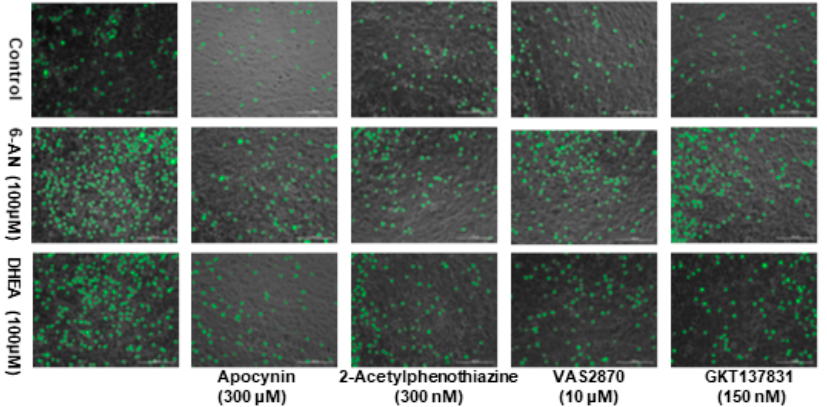
Figure 4. The effect of G6PD and NOX pharmacological inhibitors on NADPH oxidase activity, ROS in HAEC, and monocyte-endothelial cell adhesion. ( A ) NADPH oxidase activity. ( B ) ROS. ( C ) Phase- contrast images of HAEC and SC monocytic cells (scale bar: 200 μ m). Results are mean ± SEM ( n =